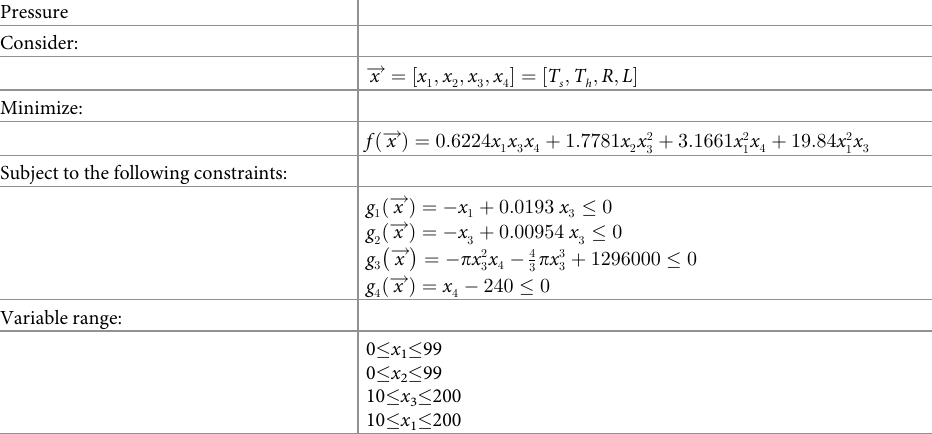
Table 9. Constraint condition of pressure vessel.